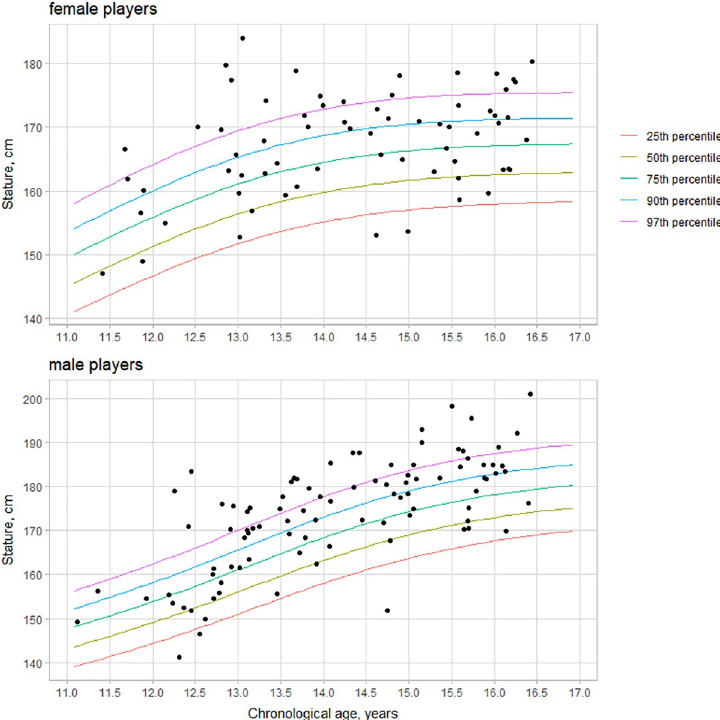
Fig 1. Statures of young female (upper panel) and male (lower panel) volleyball players by chronological age against the World Health Organization (WHO) growth references for stature.